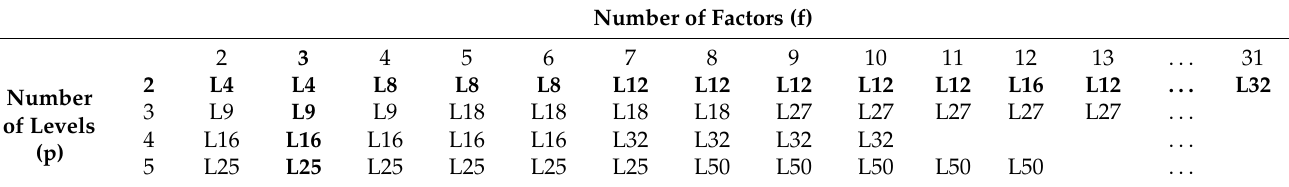
Table 7. Orthogonal Array Selection, Adapted From